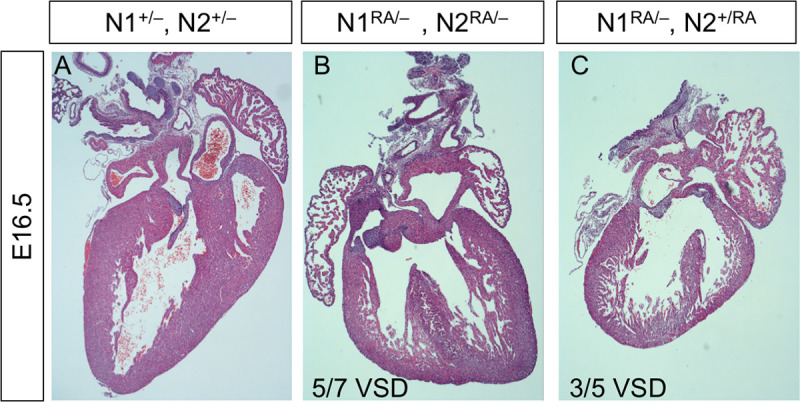
Notch1R1974A substitution compromised ventricular septum development.A. Normal heart with complete septum. B.
N1RA/–; N2RA/–heart with a severe, highly penetrant VSD. The penetrance by age shown below the image. C.
N1RA/–; N2+/RA heart with a milder, less penetrant VSD. E, embryonic day; N1RA/–; N2+/RA, Notch1 Arg1974Ala Notch2 Arg1934Ala hemizygous; VSD, ventricular septal defect.